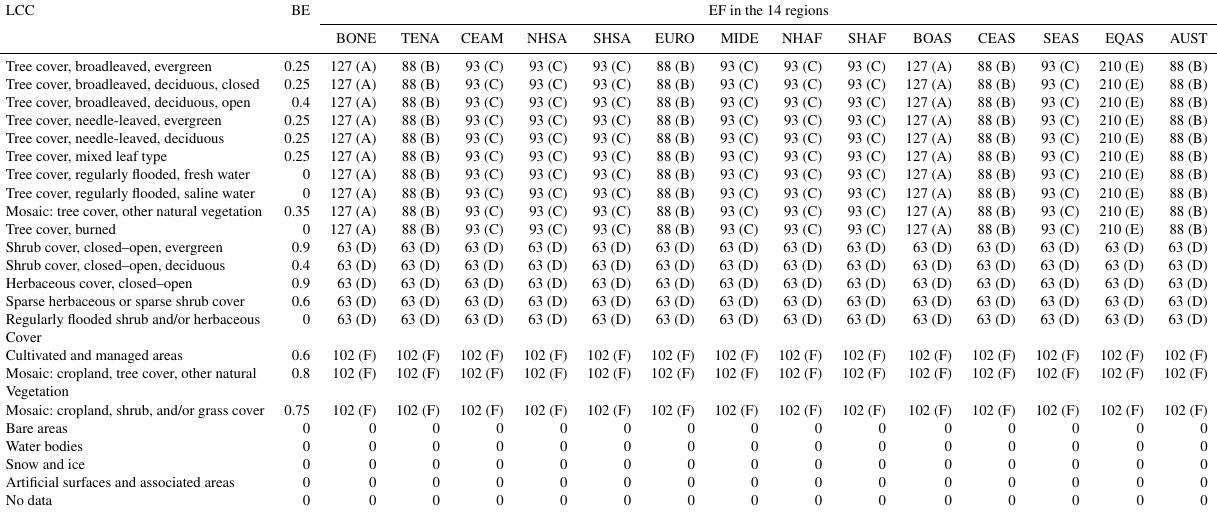
Table A1. BE and EF of CO (g COkg − 1 ) for the LCC types used in GLC2000. See Fig. A1 for abbreviations of the 14 global regions. Letters in brackets show corresponding biome types from van der Werf et al. (2017); A: boreal forest; B: temperate forest; C: tropical forest; D: savanna; E: peat; and F: